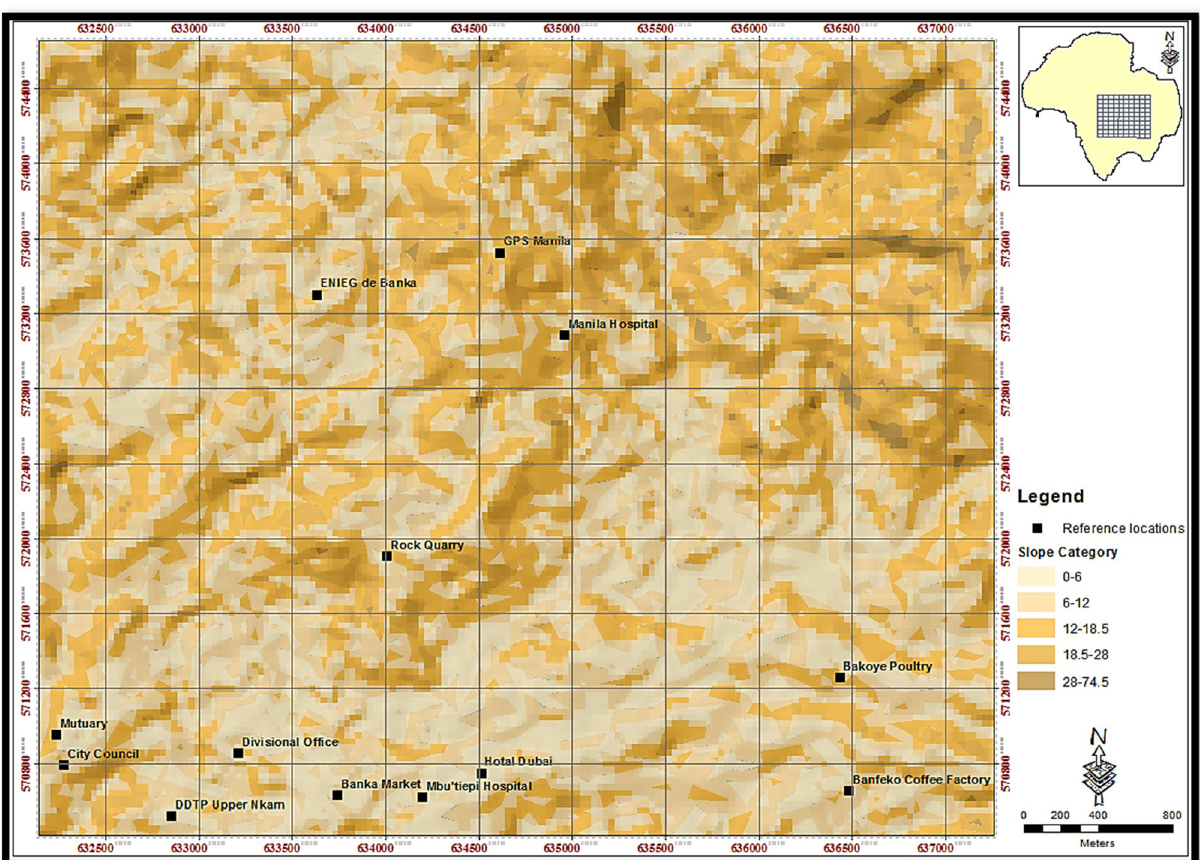
Fig. 9 Slope map of study